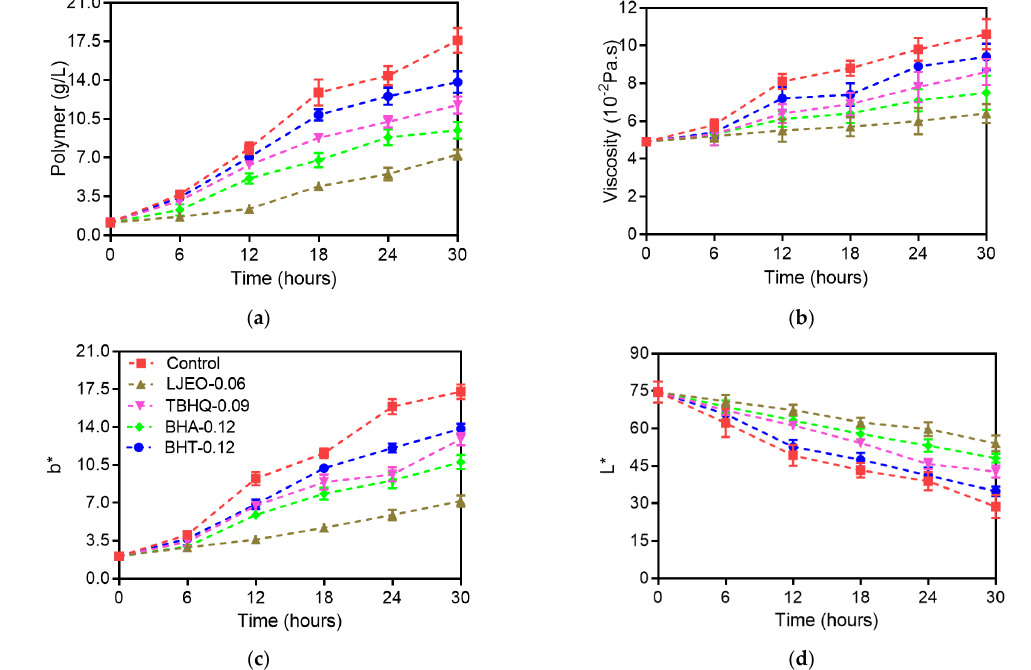
Figure 3. The values for the polymer ( a ), viscosity ( b ), b * ( c ), and L * ( d ) of sunflower oil added by nothing, LJEO (0.06 g/kg), TBHQ (0.09 g/kg), BHA (0.12 g/kg), and BHT (0.12 g/kg) during the deep ‐ frying of youtiao for 30 h. Values are expressed as means ± SD (n = 10).